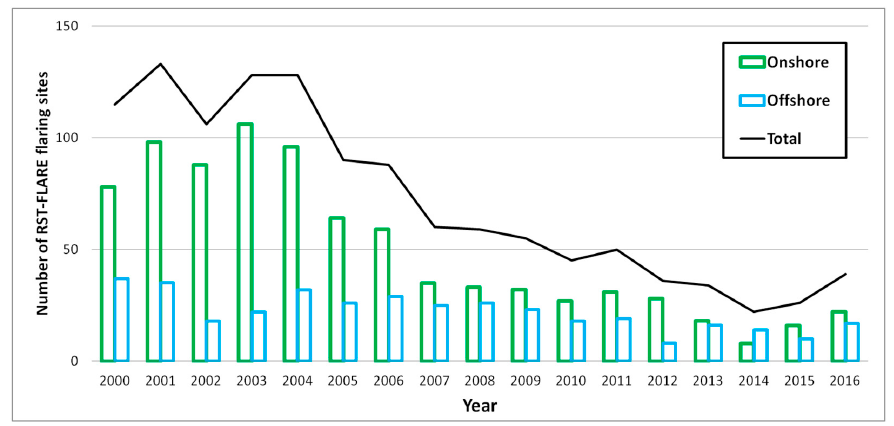
Figure 5. Temporal trend of total flaring sites detected applying RST-FLARE (black line) in the Niger Delta region, for each year from 2000 to 2016, as sum of onshore (green bars) and offshore (light blue bars) sites.